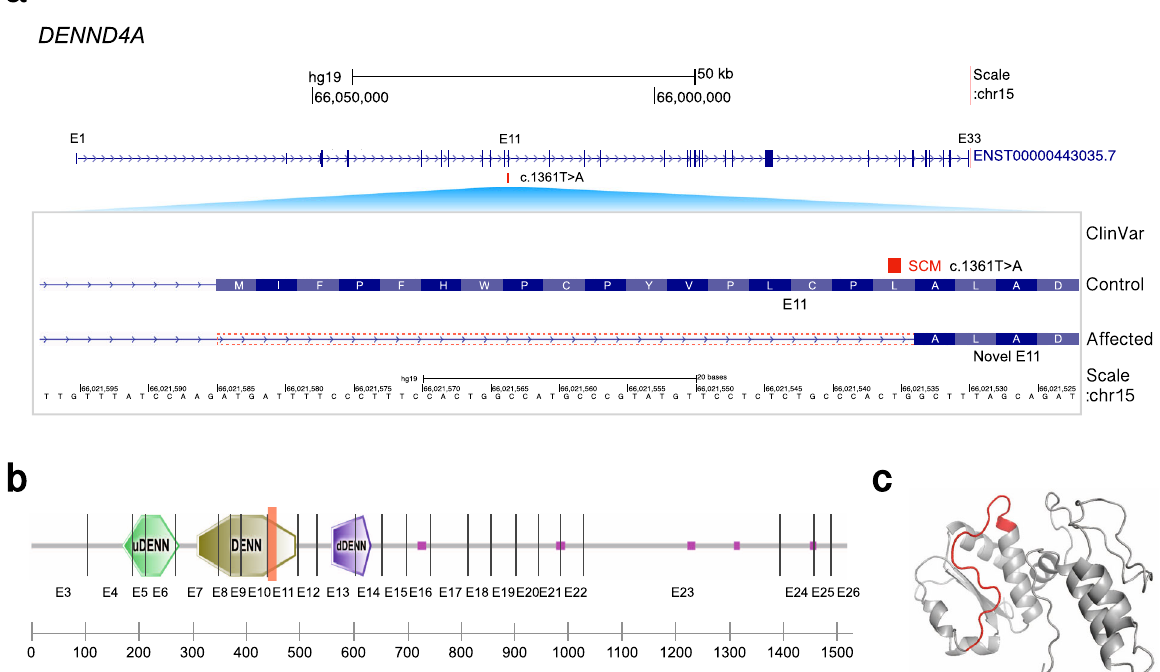
Fig. 6 Schematics of exon shrinkage by SCM found in DENND4A . a The upper panel shows the gene structure of DENND4A obtained from gene annotation data of GENCODE 48 v24. The genomic coordinate is reversed so that the direction of transcription is from left to right. The lower panel is a close-up view of the SCM and exon 11 (E11). The gene structure for a control individual is followed by that for an affected individual with the SCM (c.1361 T > A), which induces exon shrinkage. The dotted box indicates the region of the shrinkage. b Effect of the SCM on the protein domain structure. The protein domain architecture is taken from SMART 53 . The red rectangle indicates the 17-amino-acid- long fragment that is coded by the shrunken part of the exon. The vertical line indicates the position of the intron. The pink box indicates the low-complexity region. c A three-dimensional protein structural model of the DENN domain constructed by SWISS-MODEL 54 . The 17-amino- acid-long fragment supposed to be deleted by the SCM is shown in